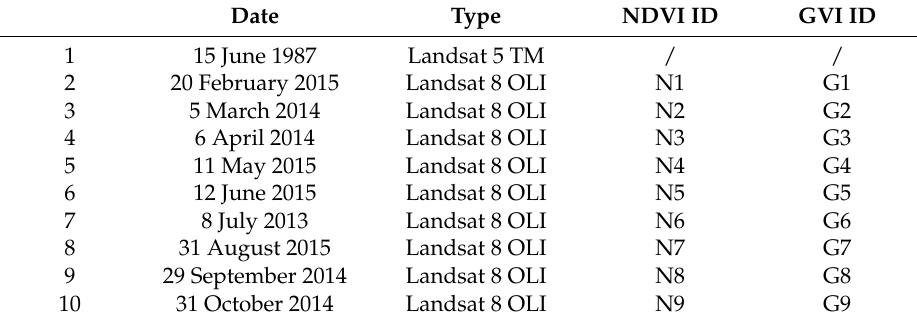
Table 1. Time series of Landsat imagery in the study area. GVI, Green Vegetation Index.